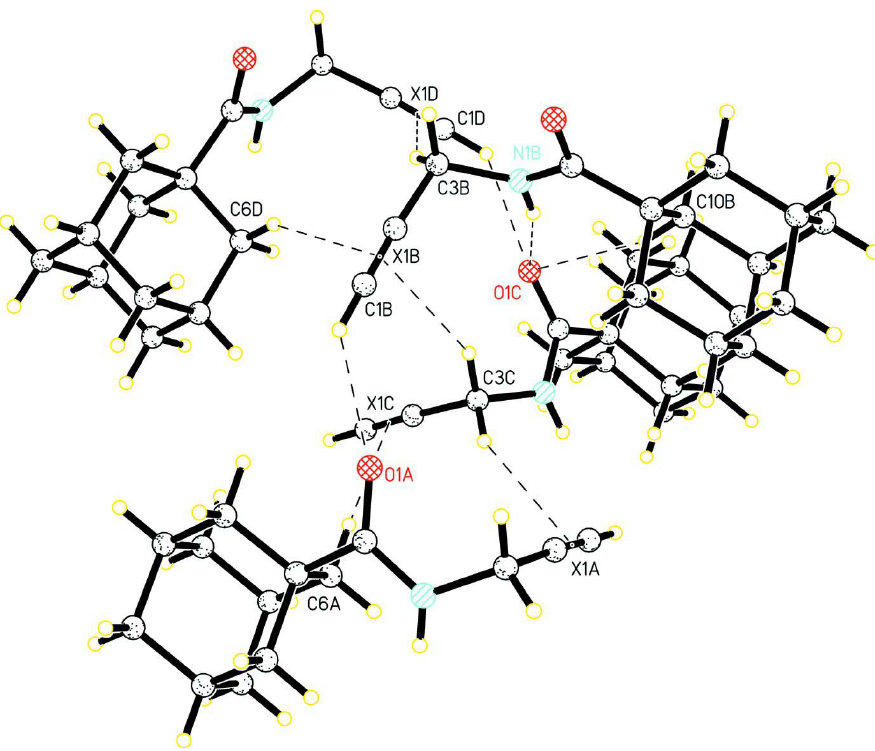
Figure 2 Detailed view of the intermolecular hydrogen bond interactions. (X1A - X1D are the centers of the alkynyl bond)